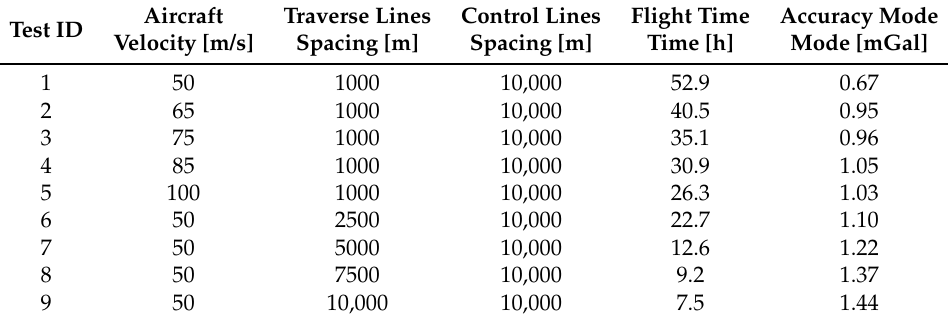
Table 1. Accuracy obtained considering different designs of the airborne